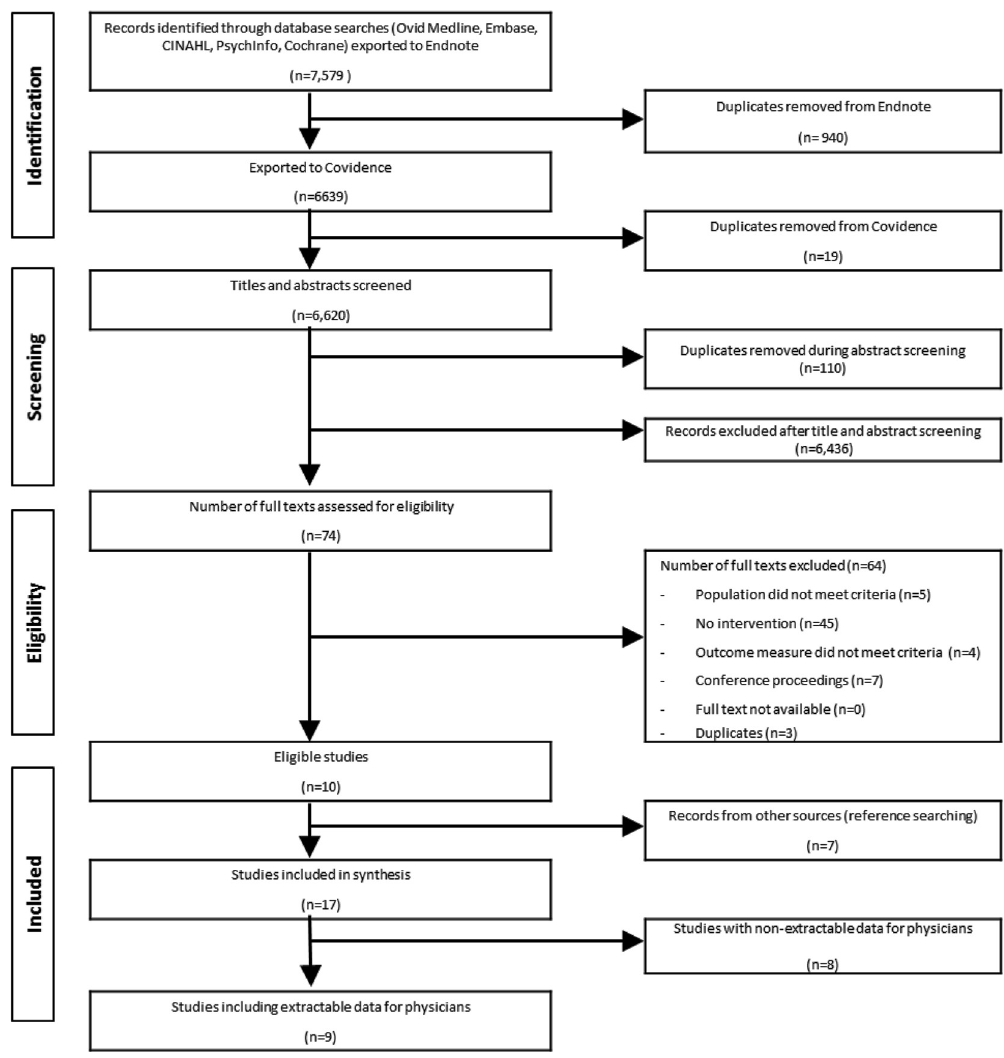
Fig 1. Prisma flow